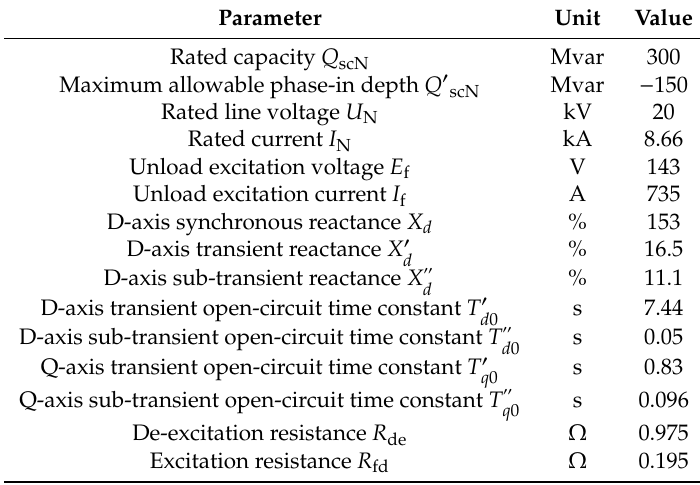
Figure 2. Wiring diagram of the single-machine infinite-bus system. Figure 2 . Wiring diagram of the single-machine infinite-bus system. Table 2. Parameters of Table 2 . Parameters of SC.